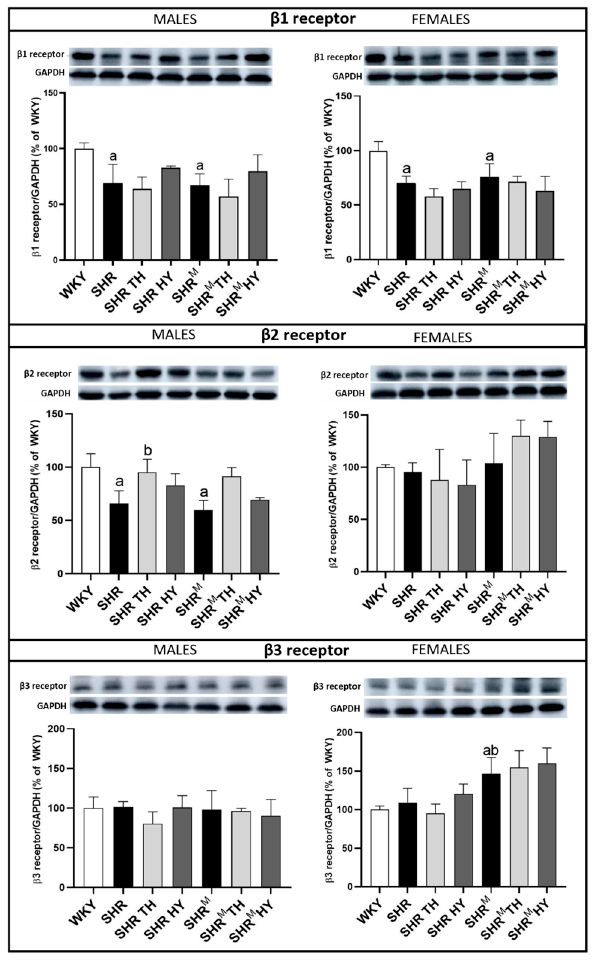
Figure 11. Myocardial protein levels of the β -adrenergic receptors (AR) determined by Western blotting. Note the reduced protein levels of β 1-AR and β 2-AR in both the SHR and SHR M strains, compared to normotensive WKY rats, as well as an increase of the β 3-AR protein in hairless SHR M females compared to wild type SHR. WKY—Wistar Kyoto normotensive control rats, SHR—wild type spontaneously hypertensive rats, TH—hyperthyroid rats, HY—hypothyroid rats and SHR M — hairless spontaneously hypertensive rats, n = 5 per group. Data are presented as means ± SD, a p < 0.05 vs. WKY, b p < 0.05 vs. SHR. One-way ANOVA and Bonferroni’s multiple comparison test were used as the statistical method.